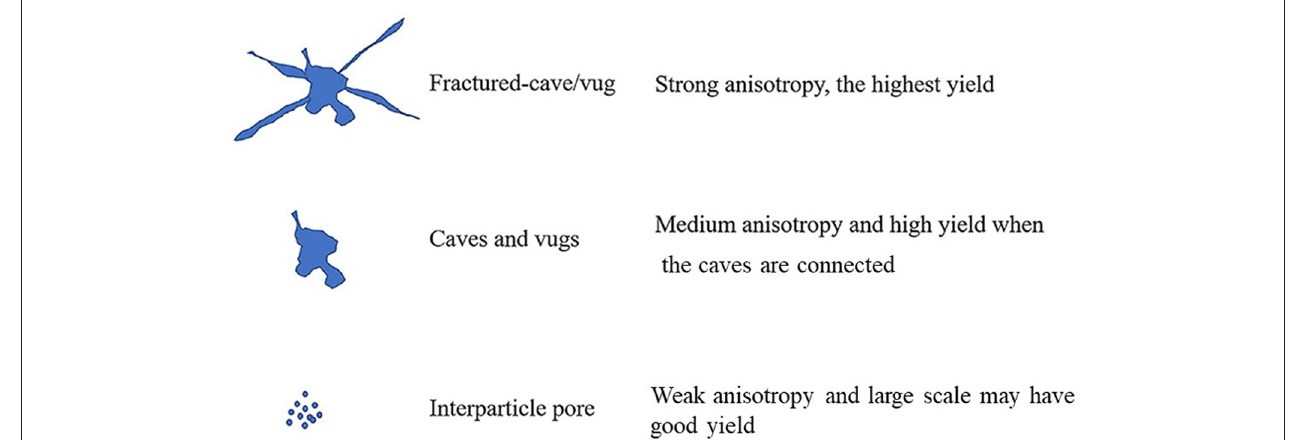
FIGURE 1 | Schematic diagram of the three investigated pore types.